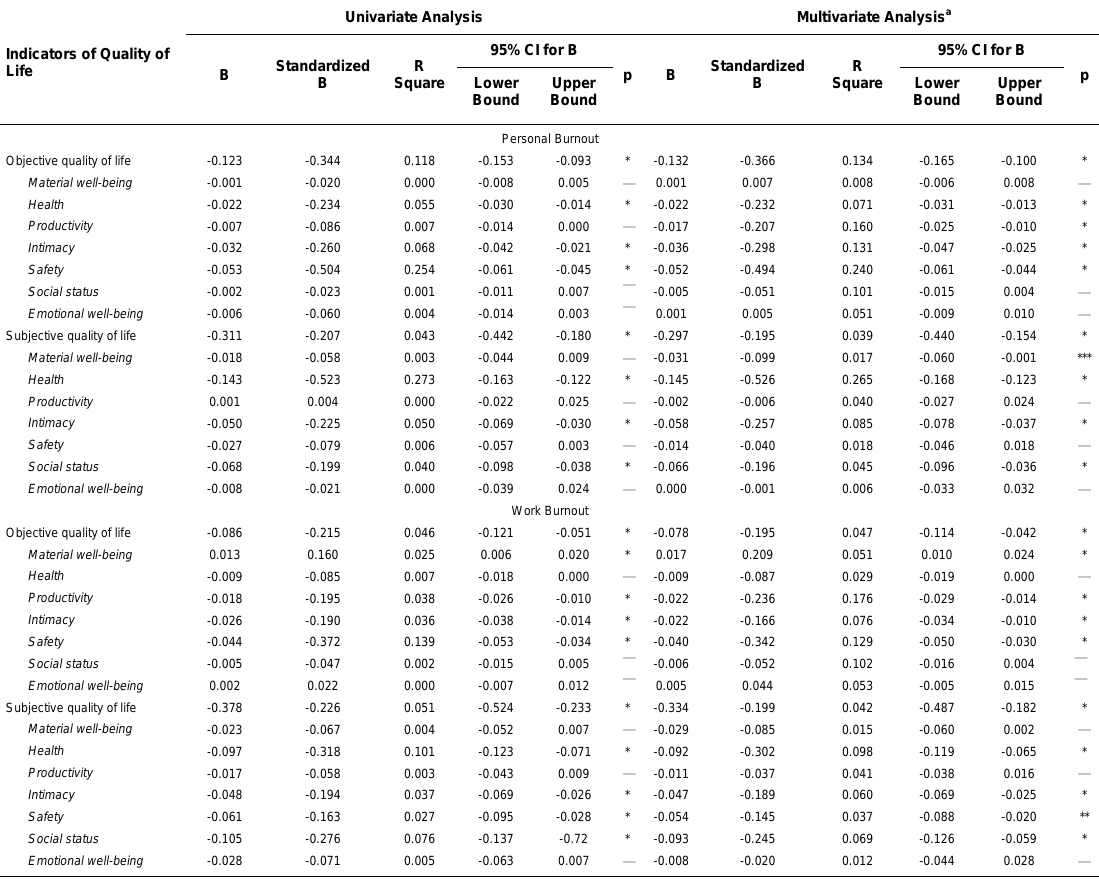
Adjusted to sex and